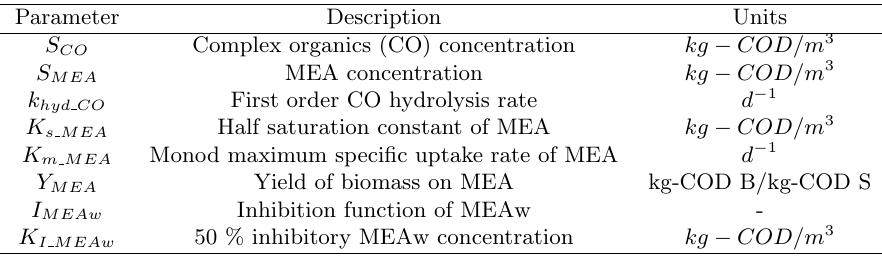
Table 3: State variables and parameters added in the extended